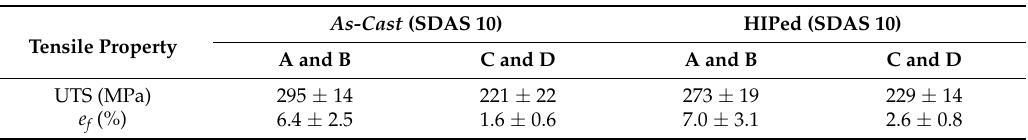
Table 4. Mechanical properties with one standard deviation of samples not having any visible oxides at the fracture